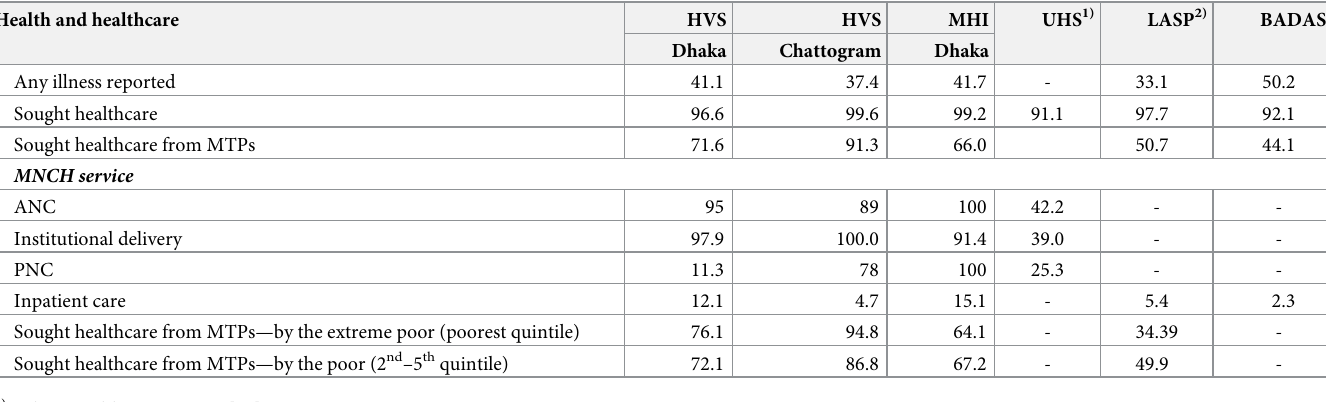
Table 8. Comparison of illness and rate of healthcare utilization of HVS and MHI with Urban Health Survey 2013, LASP 2012, and BADAS 2015. Health and